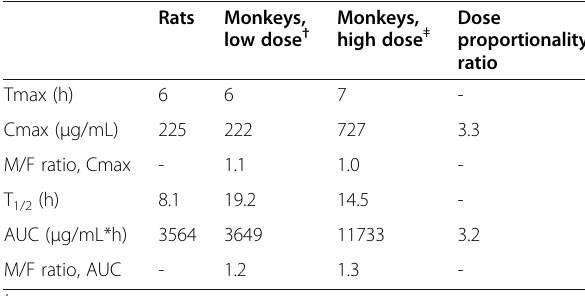
Table 1 Parameters in rats ( n = 4) and monkeys ( n = 2 female and 2 male) dosed with